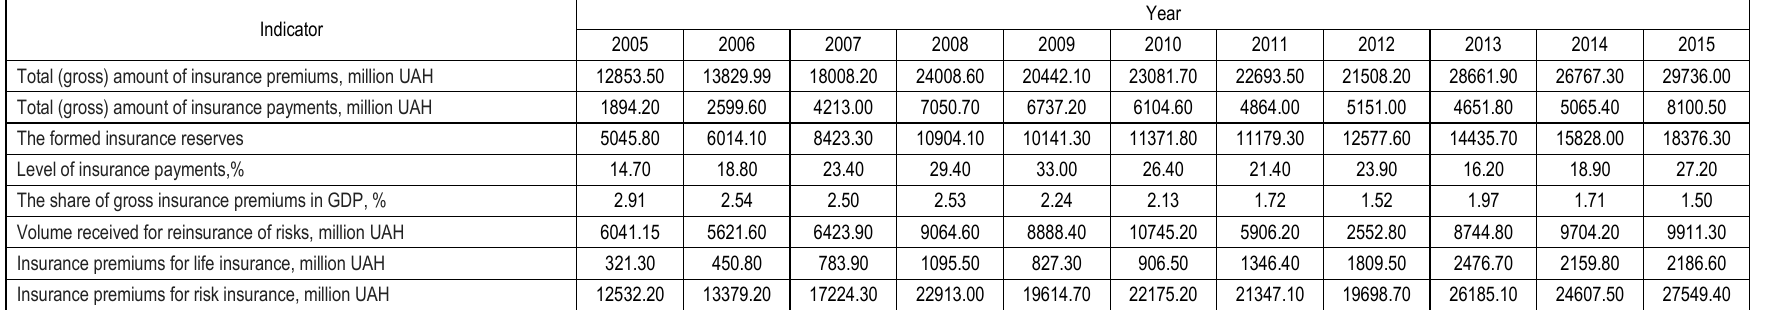
Table В. 2. Information provision for the study of the capacity of the Ukrainian insurance market in 2005 – 2015